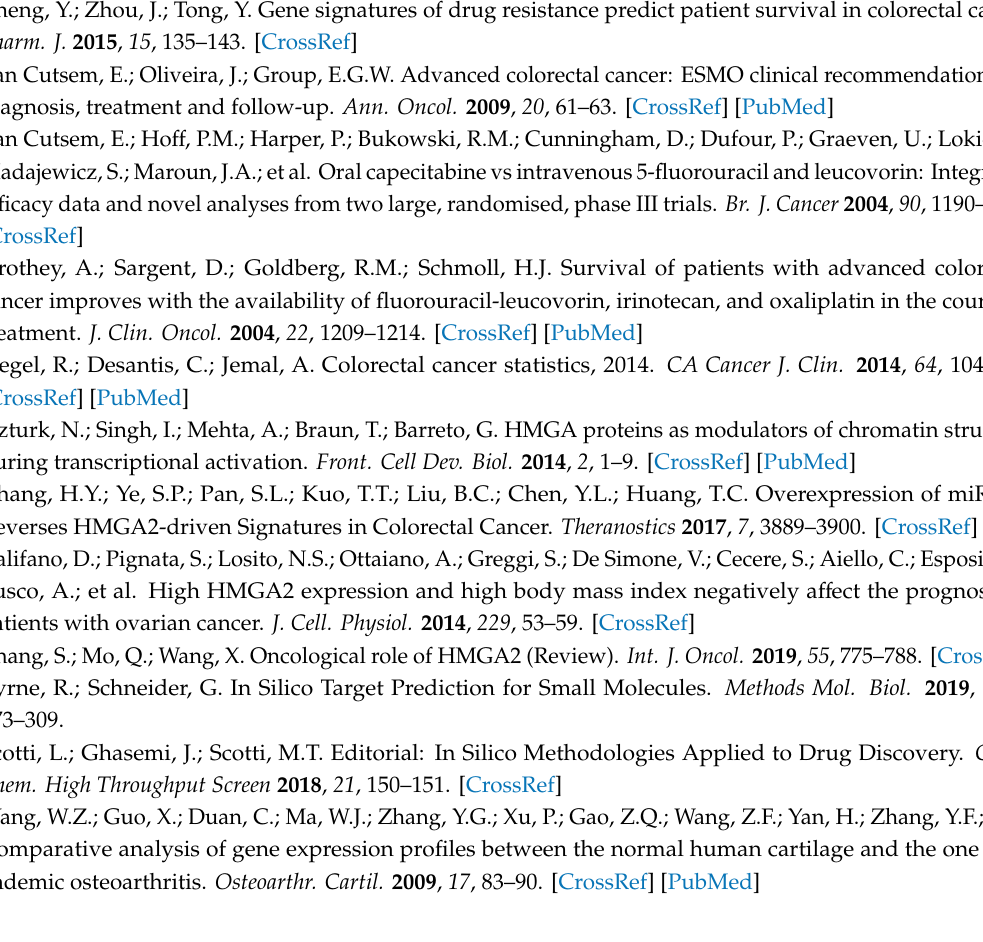
Table S1: Top 10 chemical perturbagens with a positive enrichment score for the gene expression signature of the knockdown of human high-mobility group A2 (HMGA2).Table S2: Top 10 chemical perturbagens with a negative enrichment score for the gene expression signature of the overexpression of HMGA2.Table S3: Sixty-seven overlapping genes identified from the intersection between the knockdown or the overexpression of HMGA2 through a gene set enrichment analysis